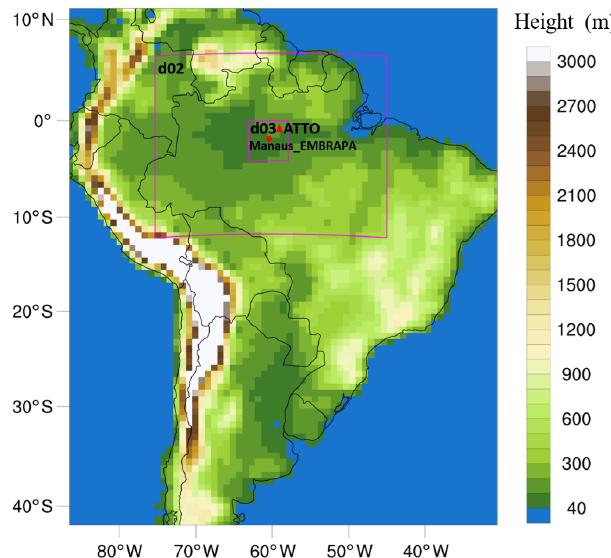
Figure 1. Model domain and orography. The outer map represents the parent domain with 75km horizontal grid spacing, and the em- bedded squares show the extents of the 15km (d02) and 3km (d03) nested domains. The red dot denotes the AERONET monitoring sta- tion; the triangle represents the ATTO site.